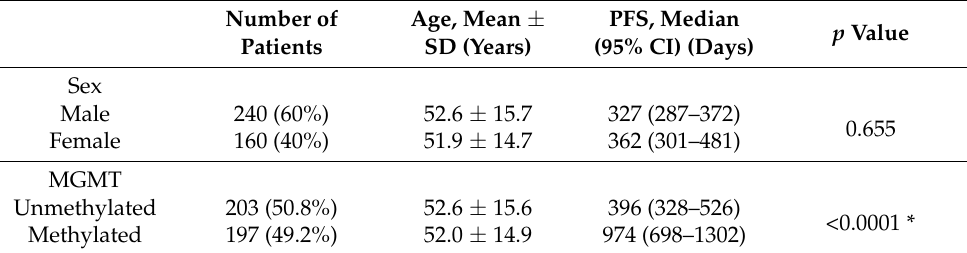
Table 1. Patient demographics and genetic information.